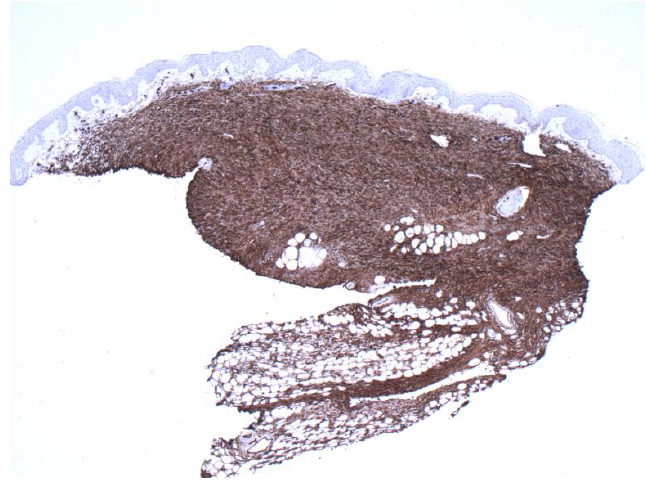
Figure 6. Diffuse and even staining was also highlighted by CD34 preparation, compared with Fig- ure 4.